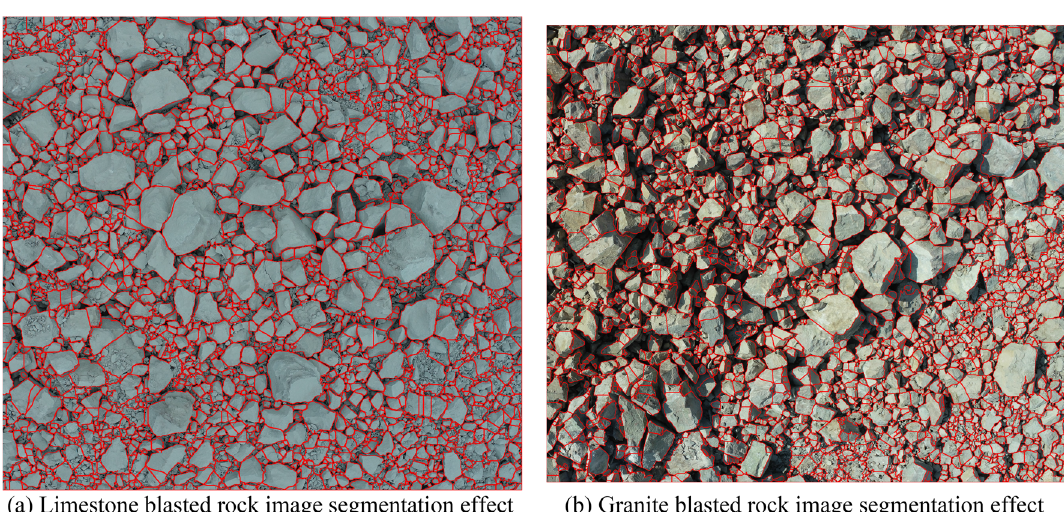
Figure 22. The segmentation effect using the segmentation method of the literature 46 .